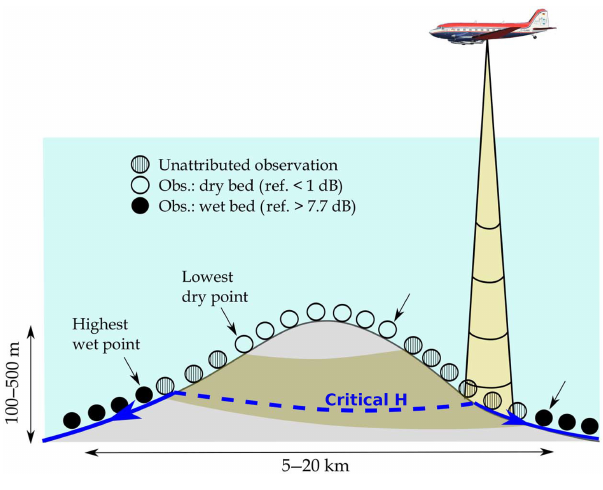
Figure 2. This figure illustrates how water and basal topography are linked with a region of flat surface for a uniform local GF. The blue line shows the presence of water at the bed and the direction of its flow. The brown area corresponds to a strip where the thermal conditions are unknown. We defined the critical thickness as the minimum thickness that allows basal melting today.